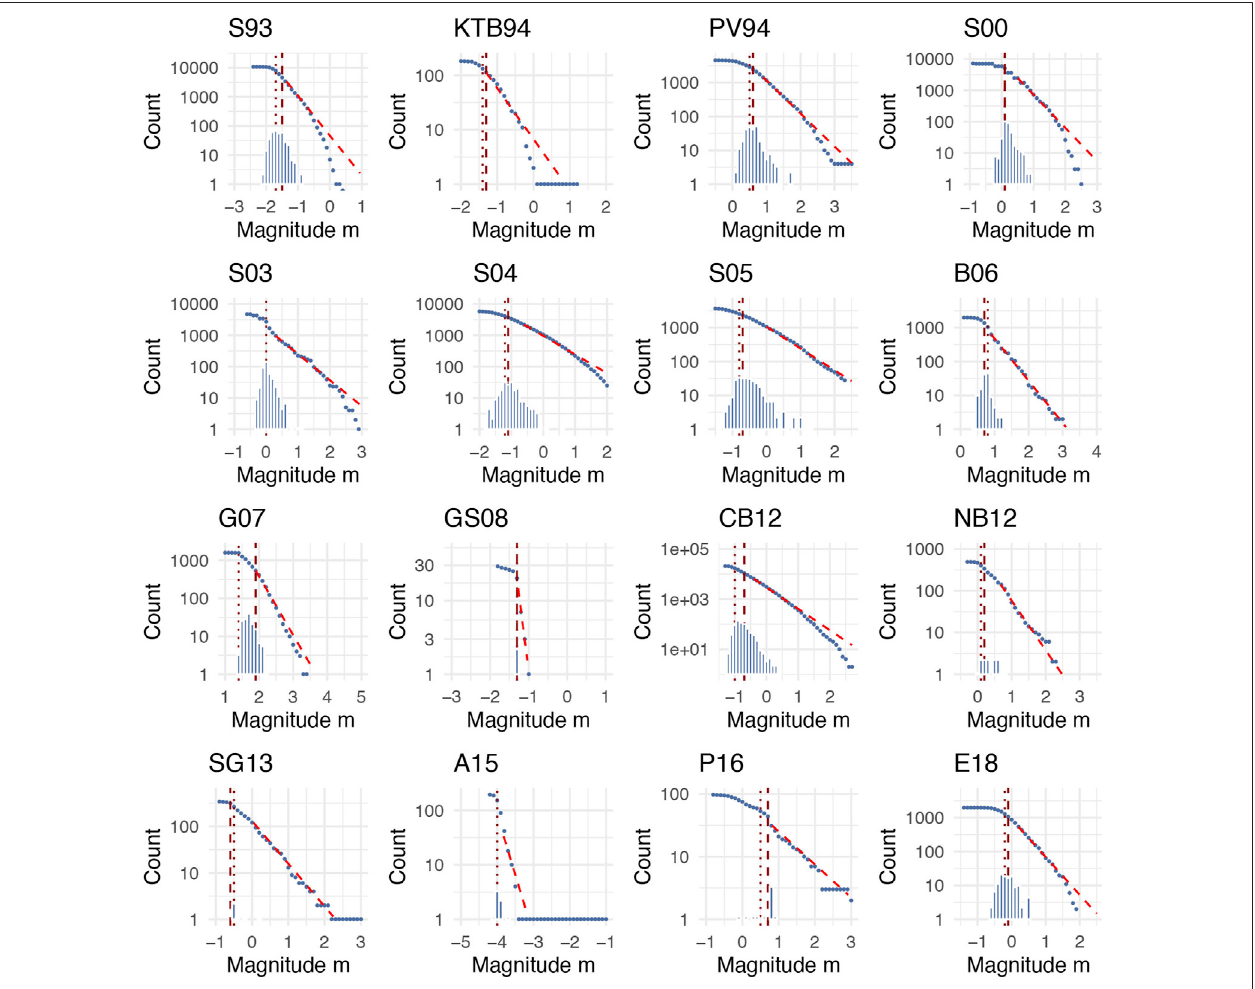
FIGURE 1 | Cumulative magnitude frequency distribution (MFD) of 16 underground stimulations. The histogram shows the m c , obs distribution derived from three- dimensional m c mapping (except for KTB94 for which case coordinates are unavailable). Parameter b (dashed red line) is estimated for m c (cid:1) q 90 ( m c , obs ) (for m c (cid:1) m c , MBASS in the KTB94 case). The vertical dotted and dashed dark-red lines represent m c , mode and m c , MBASS , respectively. See Table 2 for values.